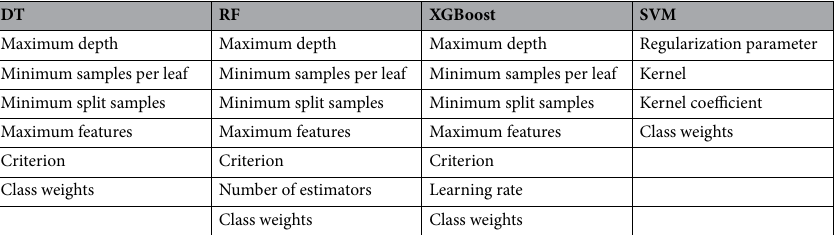
Table 3. Hyperparameters of the ML models.